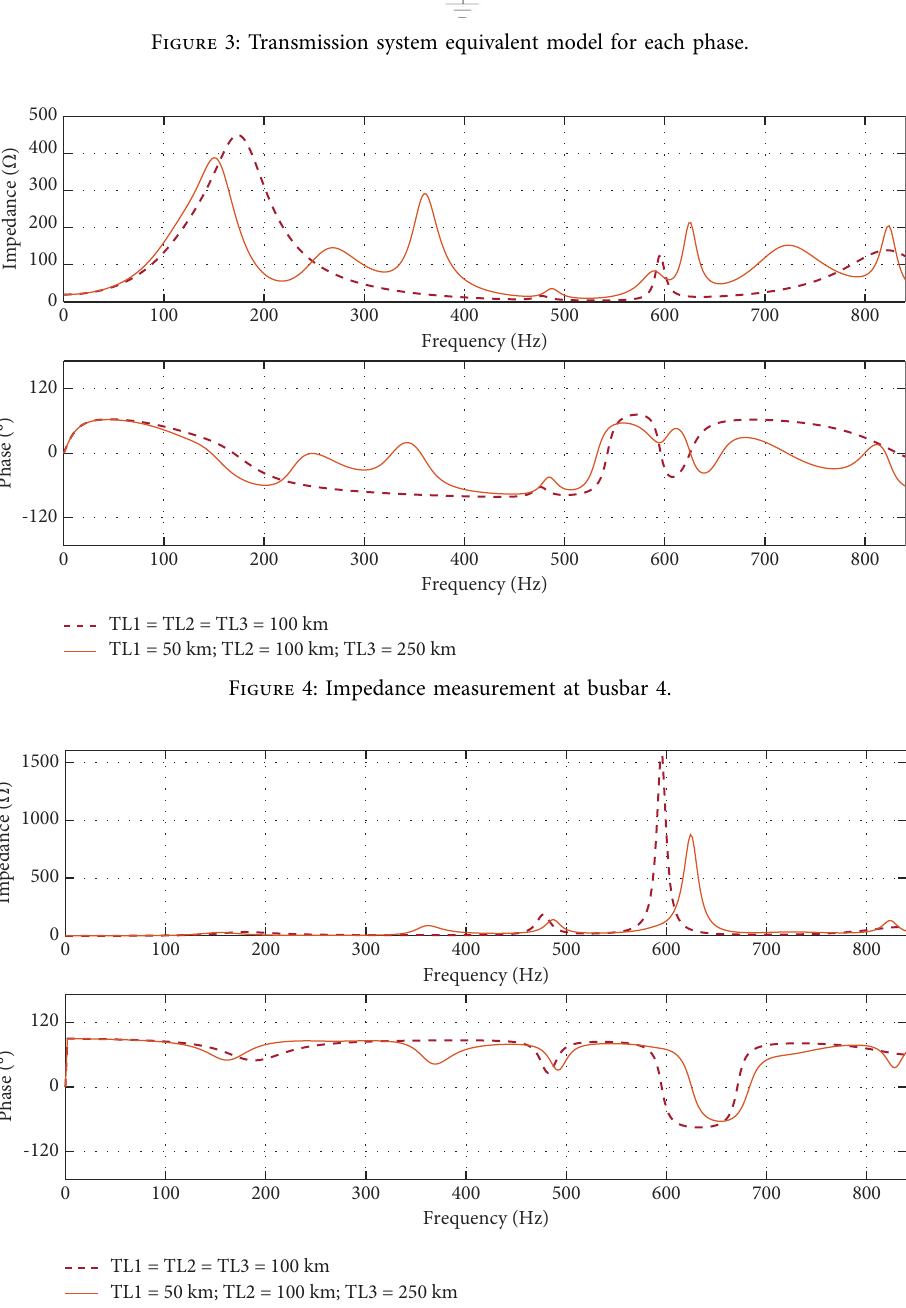
Figure 5: Impedance measurement at busbar 5.